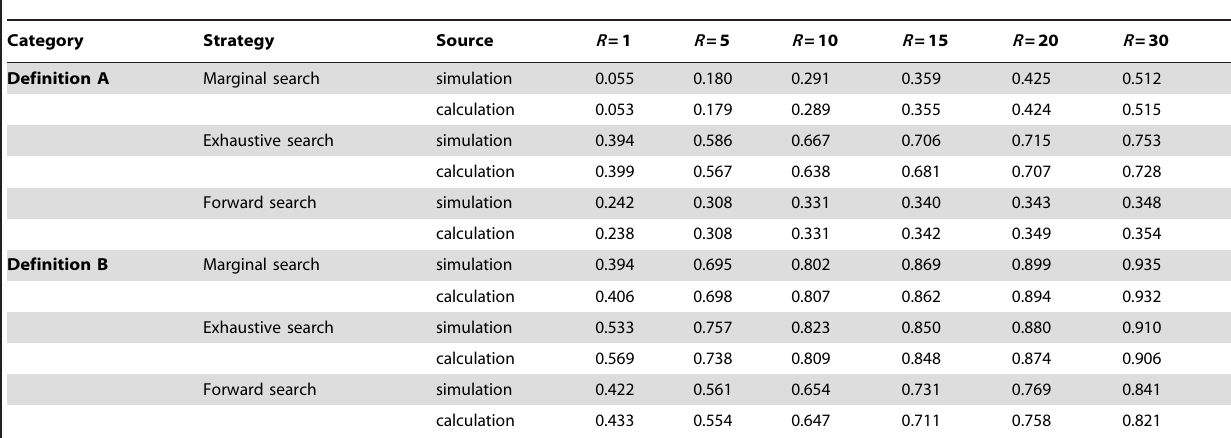
Table 2. The probability of detecting the exact true model (or both true SNPs in marginal search) under power definition A, and the probability of detecting at least one of the true SNPs under power definition B, with the false discovery number R varying. b 1 = b 2 =0.1, b 3 = 1.4.